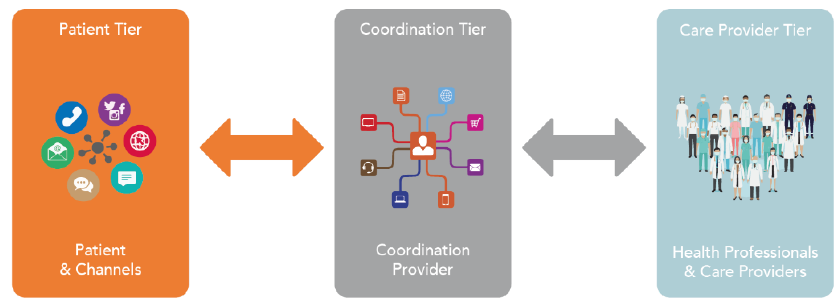
Figure 2. Conceptual model of multichannel interaction.